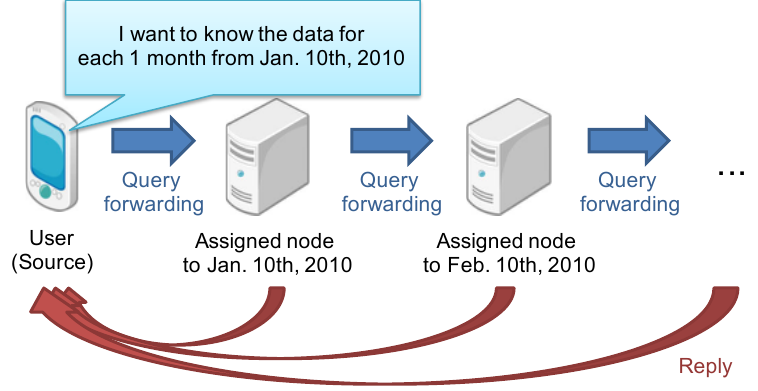
Figure 3. The assumed forwarding of interval queries.